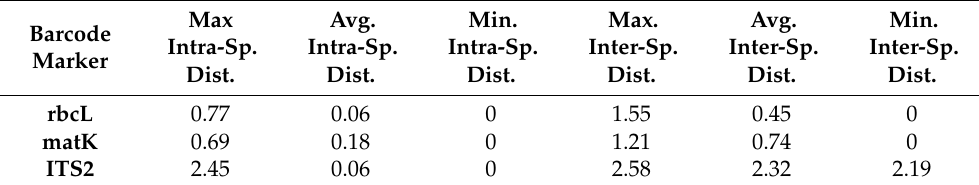
Table 2. Intra- and interspecific genetic